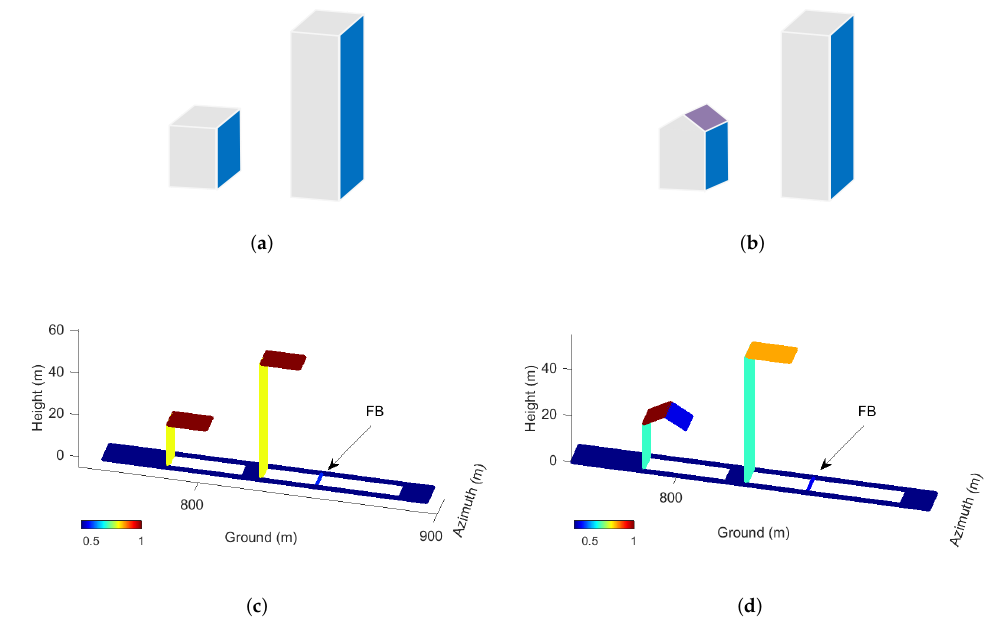
Figure 9. Image of ( a ) the simulated scene 1, ( b ) the simulated scene 2, ( c ) the single-channel scattering points of the simulated scene 1, and ( d ) the single-channel scattering points of the simulated scene 2. The color maps in ( c ) and ( d ) indicate the normalized scattering